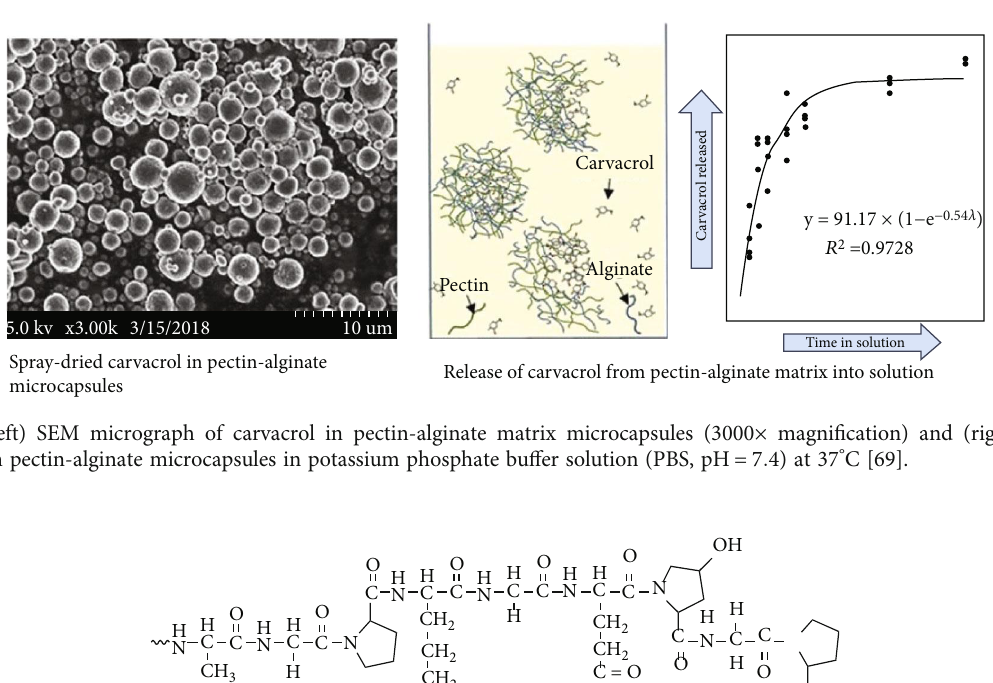
Figure 23: Representative gelatin structure;